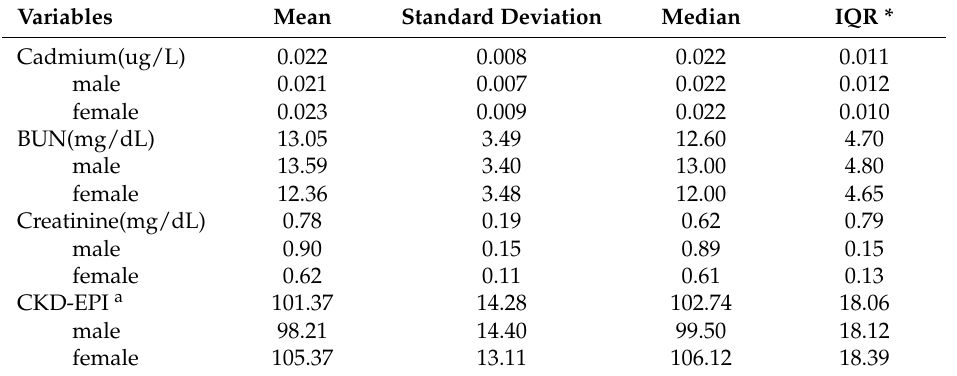
Table 2. Biochemical indicators of